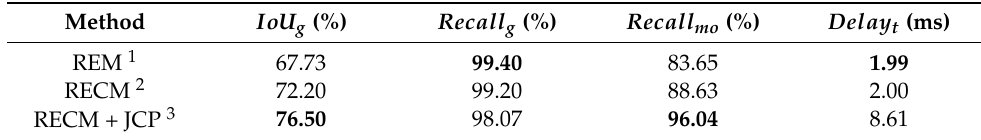
Table 1. The influence of each module of the proposed algorithm on